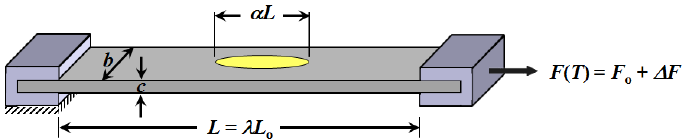
Figure 1. Schematic of photomechanical actuator modeled in this report. The elliptical region represents the uniformly heated length where either energy Q (in Model 1) or power P in (in Models 2 and 3) is absorbed. This region differs from the illuminated region based on the degree of thermal spreading. The model treats the strip as one-dimensional in length. The lateral dimensions only are used to evaluate thermal mass and surface area for establishing heating and cooling rates; e.g., in Equation (12).